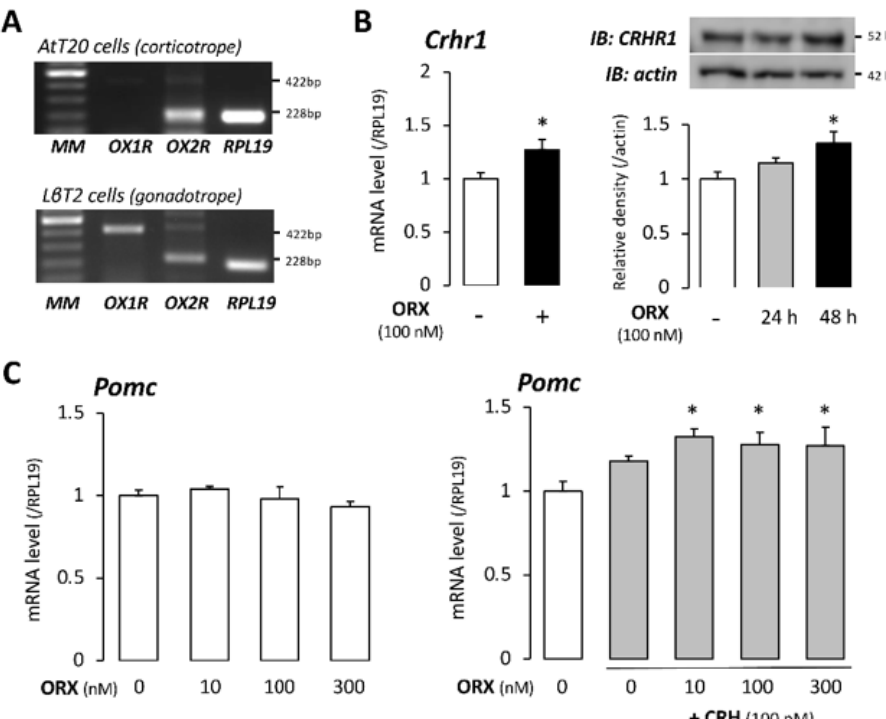
Figure 1. Expression of orexin receptors and the effect of orexin A on CRH receptor and POMC expression in AtT20 cells. ( A ) The expression of mRNAs encoding OX1R, OX2R, and RPL19 was examined by RT − PCR in AtT20 cells compared with that in mouse gonadotrope L β T2 cells. MM: molecular weight marker. ( B ) After preculture, cells were treated with orexin (ORX) in serum-free media. After 24 − h culture, total cellular RNA was extracted, and after 24 − h or 48 − h culture, cell lysates were extracted. The mRNA expression levels of Crhr1 were quantified by qPCR, and the expression levels of target genes were standardized by the RPL19 level in each sample. The cell lysates were analyzed by immunoblotting (IB) with anti − CRHR1 and anti-actin. ( C ) After preculture, cells were treated with ORX alone or with the combination of ORX and CRH in serum-free media. After 24 − h culture, total cellular RNA was extracted, and the mRNA expression levels of POMC were quantified by qPCR. The expression levels of target genes were standardized by the RPL19 level in each sample. Results are shown as means ± SEM of data from at least three independent experiments. Statistical analysis was performed by the unpaired t − test ( B ) or ANOVA ( B , C ). * p < 0.05 vs. between the control groups.